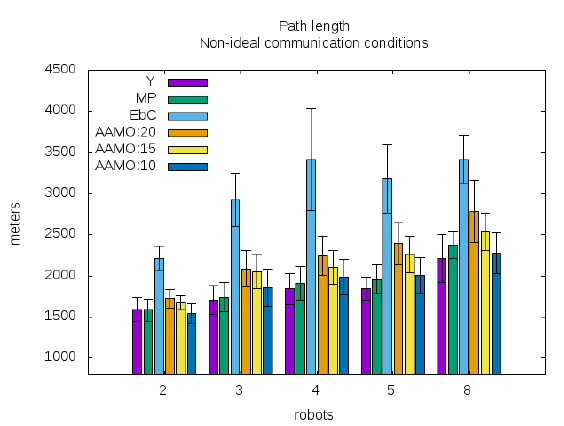
Figure 24. Path length (PL) under non-ideal communication conditions.